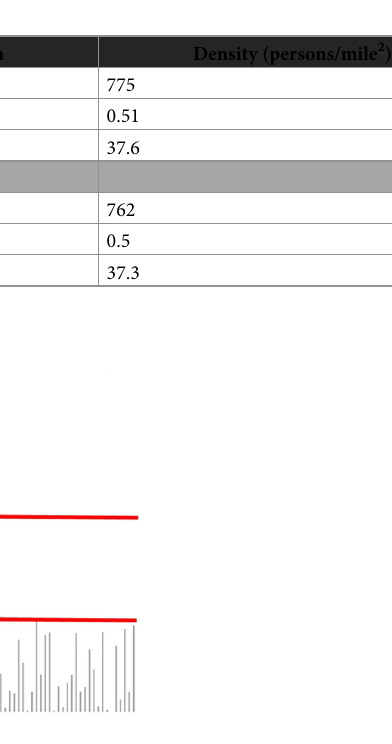
Fig 1. High and low altitude counties by elevation (m). Red lines mark the definition of high altitude ( > 2133m) and low altitude ( <